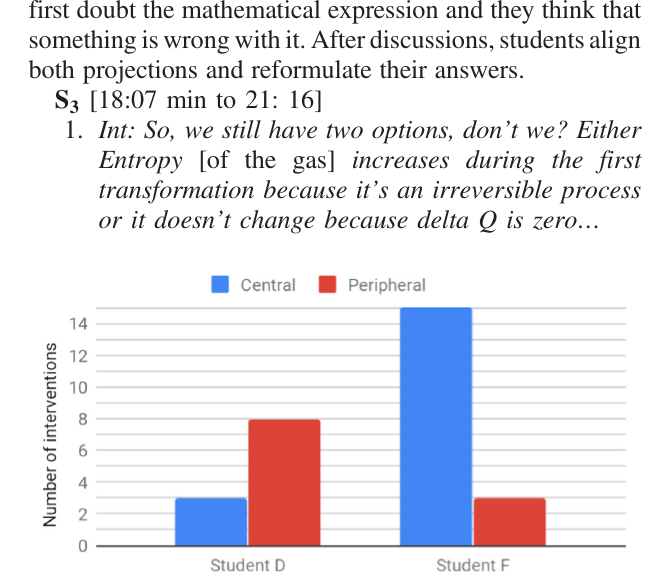
FIG. 7. Students interventions during the whole segment